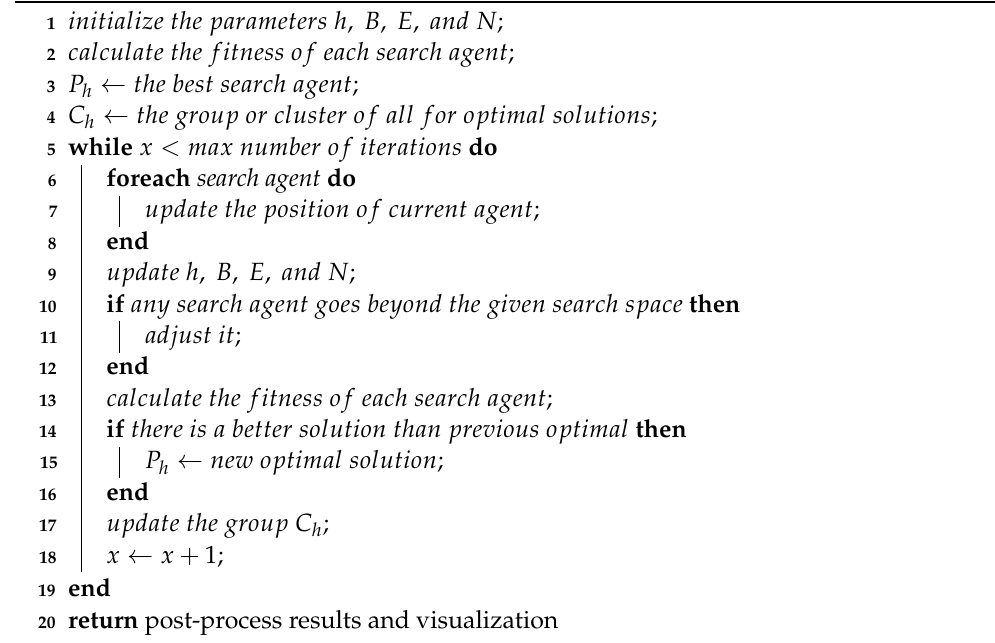
Algorithm 4: Spotted Hyena Optimizer